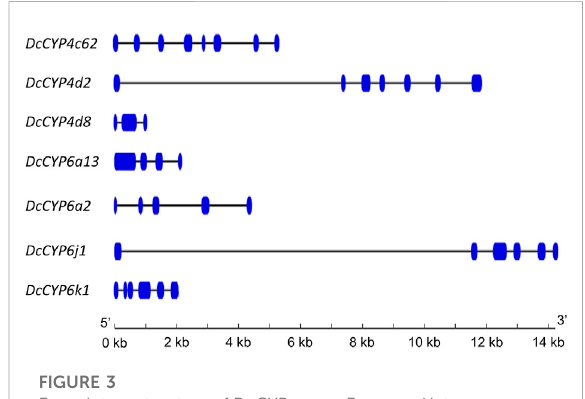
FIGURE 3 Exon-intron structure of DcCYP genes. Exons and intronsare